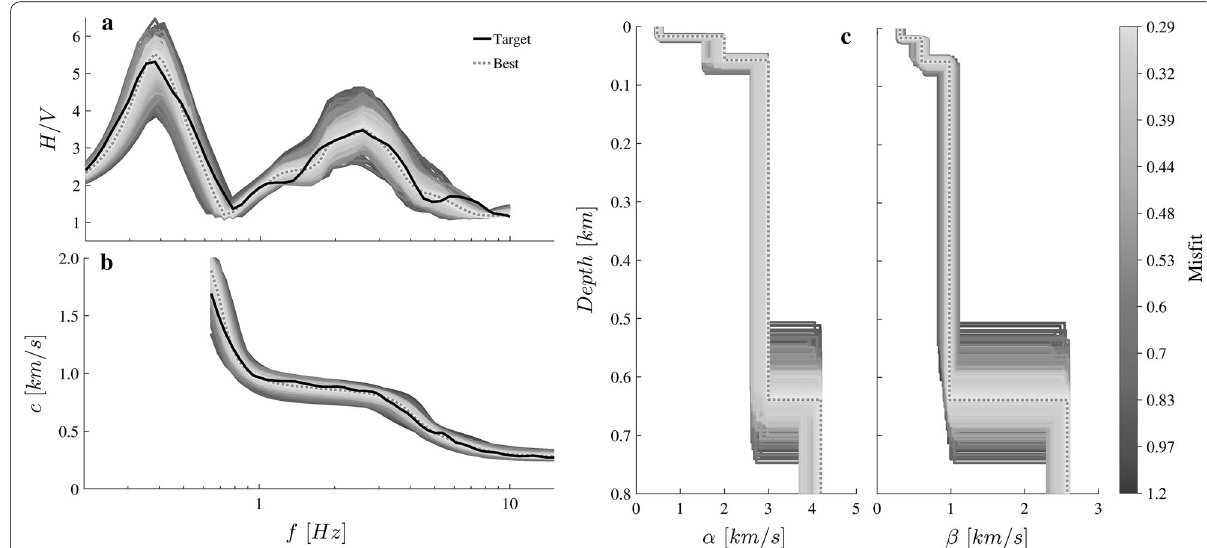
Fig. 5 Results of the inversion for one location at the mouth of Bajo Andarax River (SE Spain). a H / V target and theoretical for the best‑fitting model. b Rayleigh (fundamental mode target and theoretical dispersion curve for the best model. c Velocity profile and gray curves are those of trial models generated by the iterative method. Misfits are less than two times the final error (after Piña‑Flores et al.